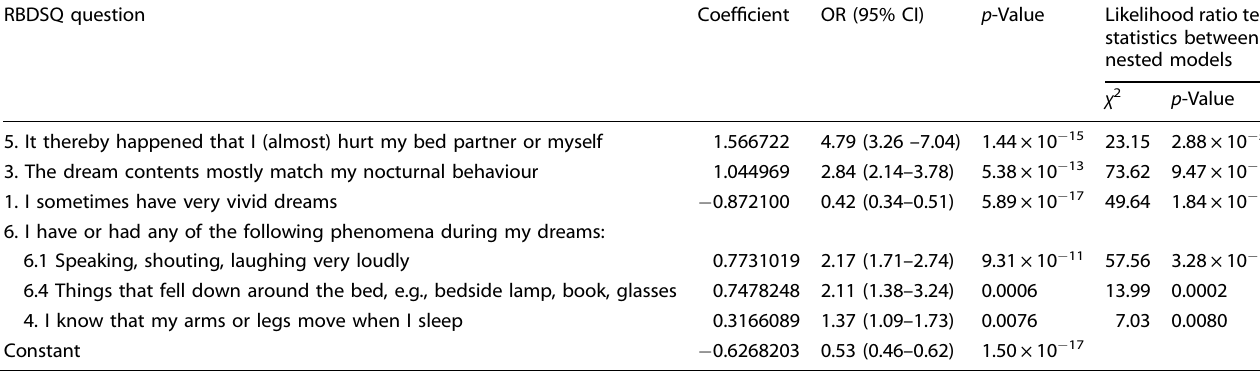
Table 2. Results of multivariate logistic regression analyses of the questions that make up the REM-sleep behaviour Screening Questionnaire